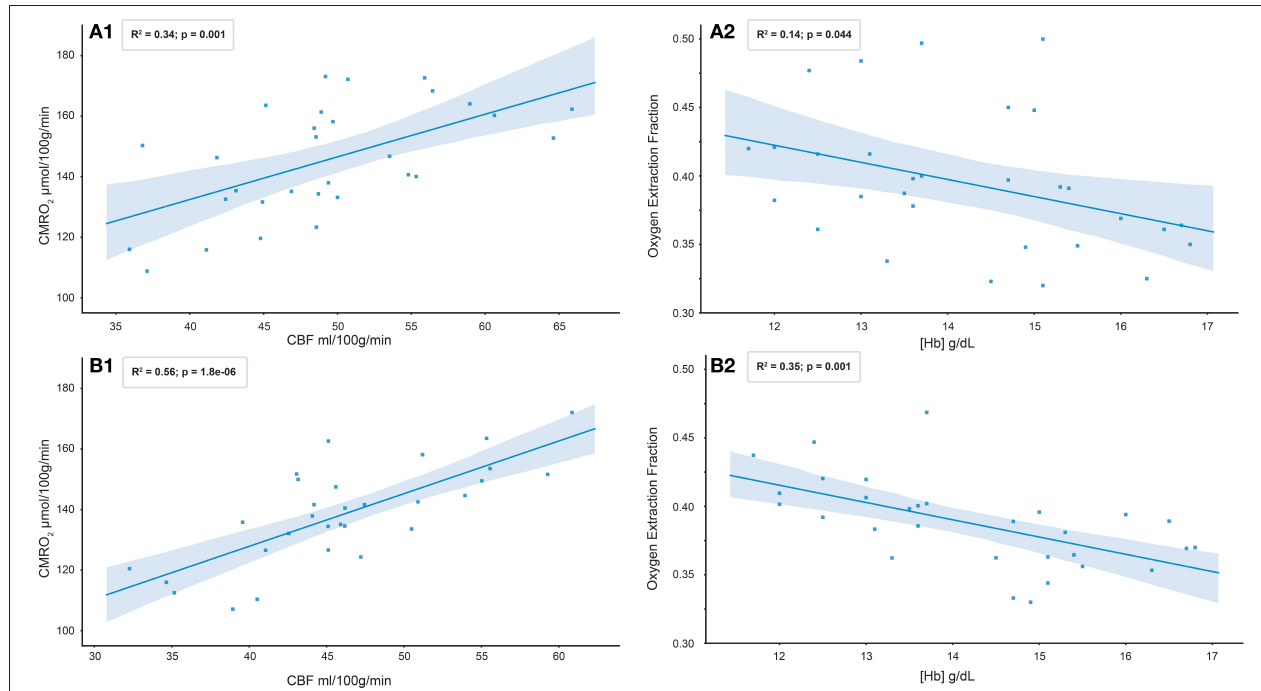
FIGURE 5 | Scatter plots of gray matter C8F-CMRO 2 and [Hb]-OEF relationships observed with rNLS (A1 and A2) and ML ensemble (B1 and B2) methods across 30 healthy volunteers.